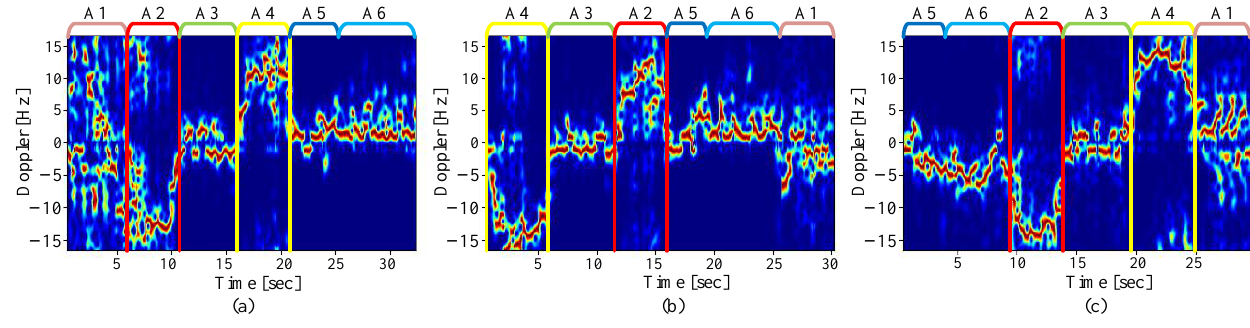
Figure 12. The spectrogram of the sequences ( a ) S1, ( b ) S2 and ( c )